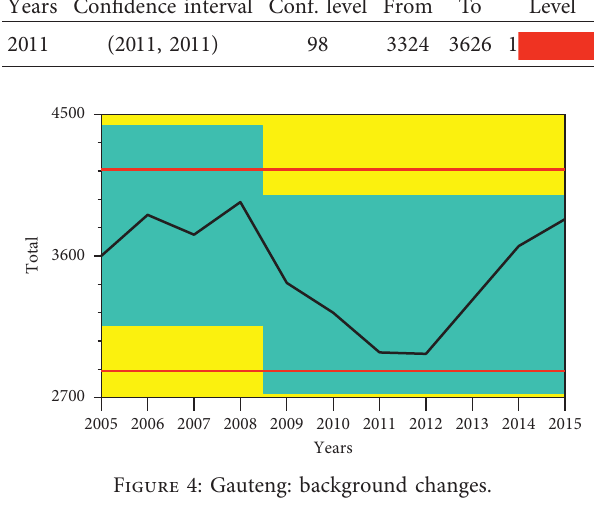
Figure 7: Western Cape: CUSUM plot. Table 6: Table of significant changes for murder in Western Cape. Years Confidence interval Conf. level From